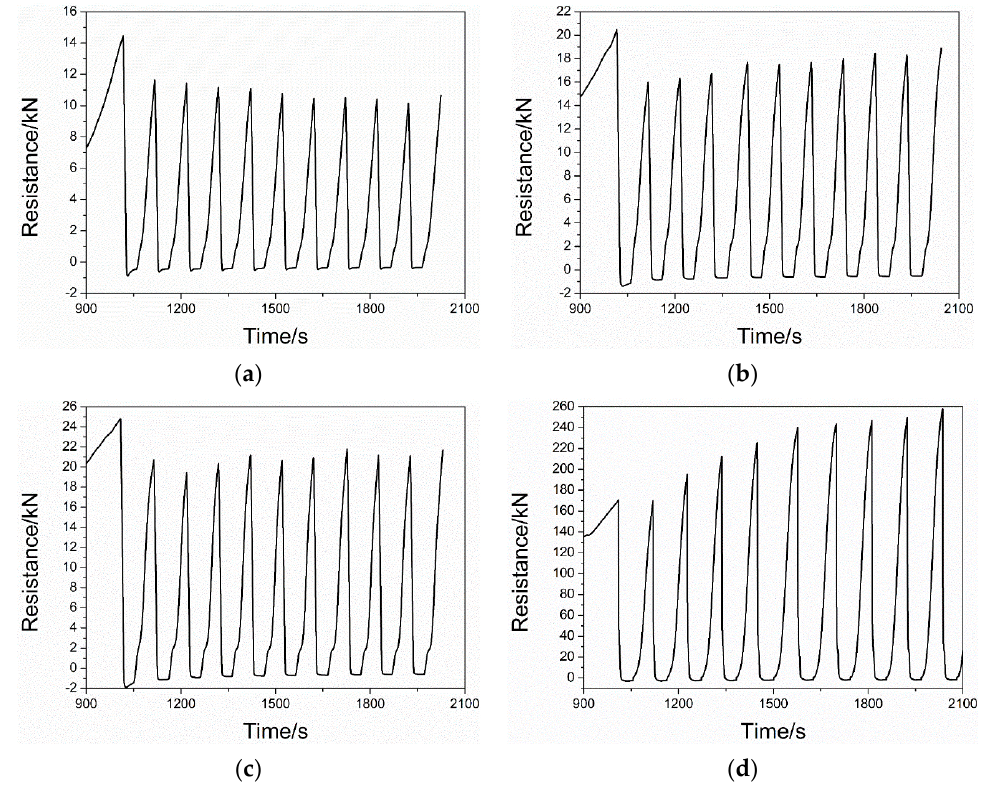
Figure 20. Resistance of different thickness models in the repeated penetration tests: ( a ) 16 mm; ( b ) 25 mm; ( c ) 30 mm; ( d ) 30 cm.